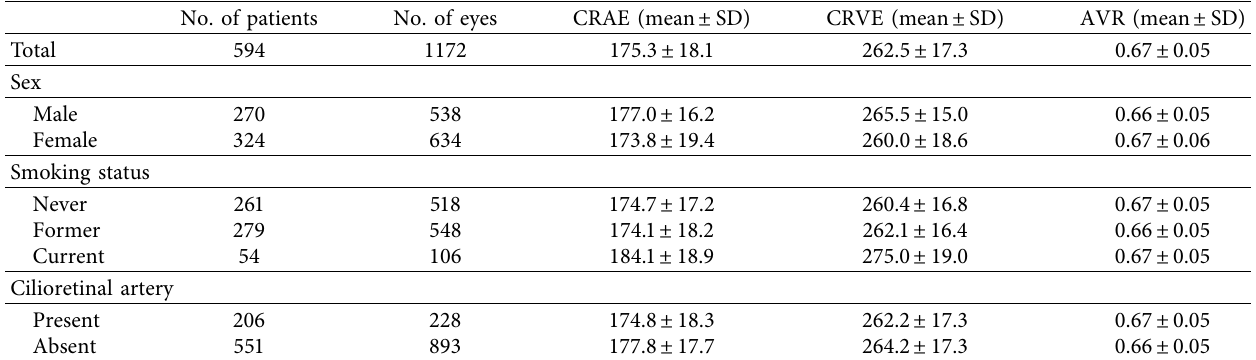
Table 1: Retinal vessel diameters based on patient demographic and clinical